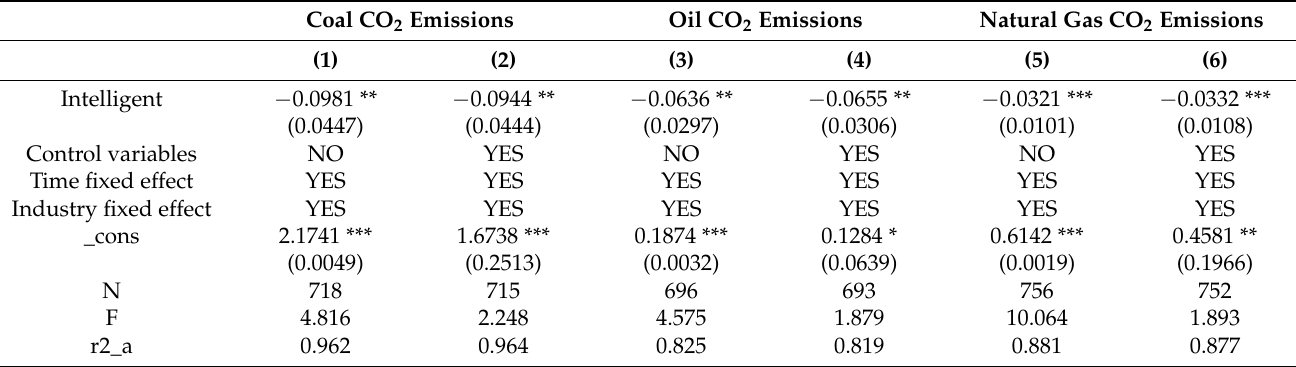
Table 3. The Impact of Intelligent Manufacturing on Different Types of Emission